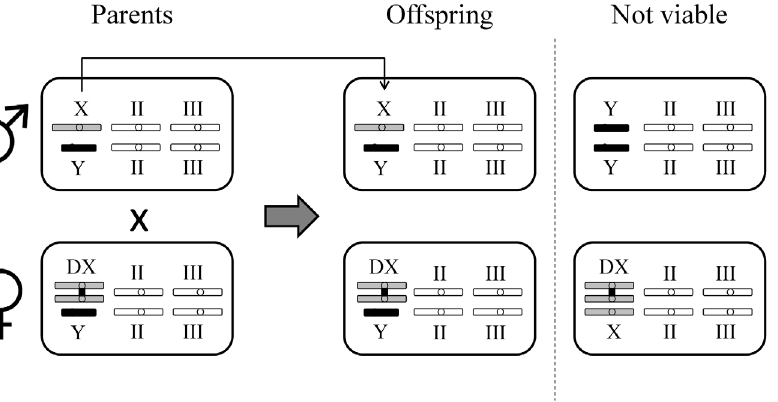
Figure 1. MLX evolution protocol. Males are mated to females with a double X-chromosome (DX), which forces father-son transmission of the X- chromosome, and produces wildtype males with a paternally inherited X-chromosome and a maternally inherited Y-chromosome. New DX females with a paternally inherited Y-chromosome are also produced. Triple-X and double-Y individuals are not viable. doi:10.1371/journal.pone.0070493.g001 PLOS ONE |